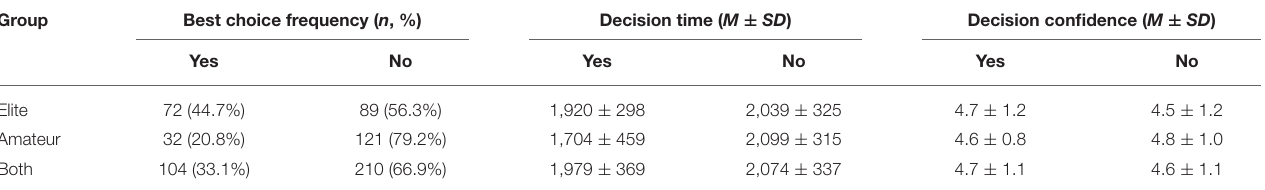
TABLE 2 | Frequencies of selected (yes) and non-selected (no) best choice, and respective decision times (in ms) and confidences (Likert-type scale) in amateur and elite players. Group Best choice frequency ( n , %)